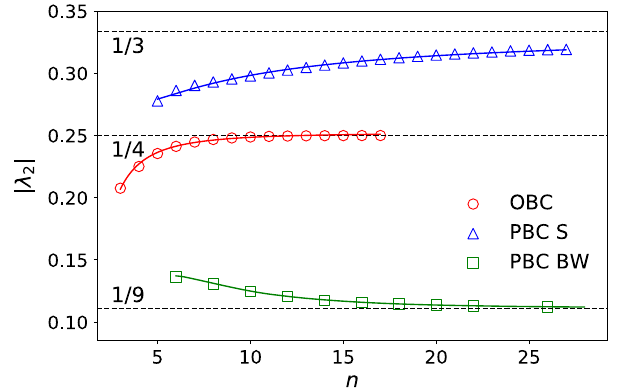
FIG. 21. Eigenvalue j λ 2 j for OBC, and PBC with the S configuration (the equivalence class p ¼ 1 ) and BW configura- tion ( p ¼ n= 2 ) for the 2-qubit XY gate. The extrapolated values in the TDL (lines) are obtained from the fits (full curves) to numerical data (symbols). The fits are j λ 2 ð n Þj ¼ 0 . 252 þ 0 . 008 =n − 0 . 43 =n 2 (OBC), j λ (PBC, p ¼ 1 ), and j λ 2 ð n Þj ¼ 0 . 114 – 0 . 20 =n þ 4 . 7 =n 2 − 16 =n 3 (PBC, p ¼ n= 2 ).